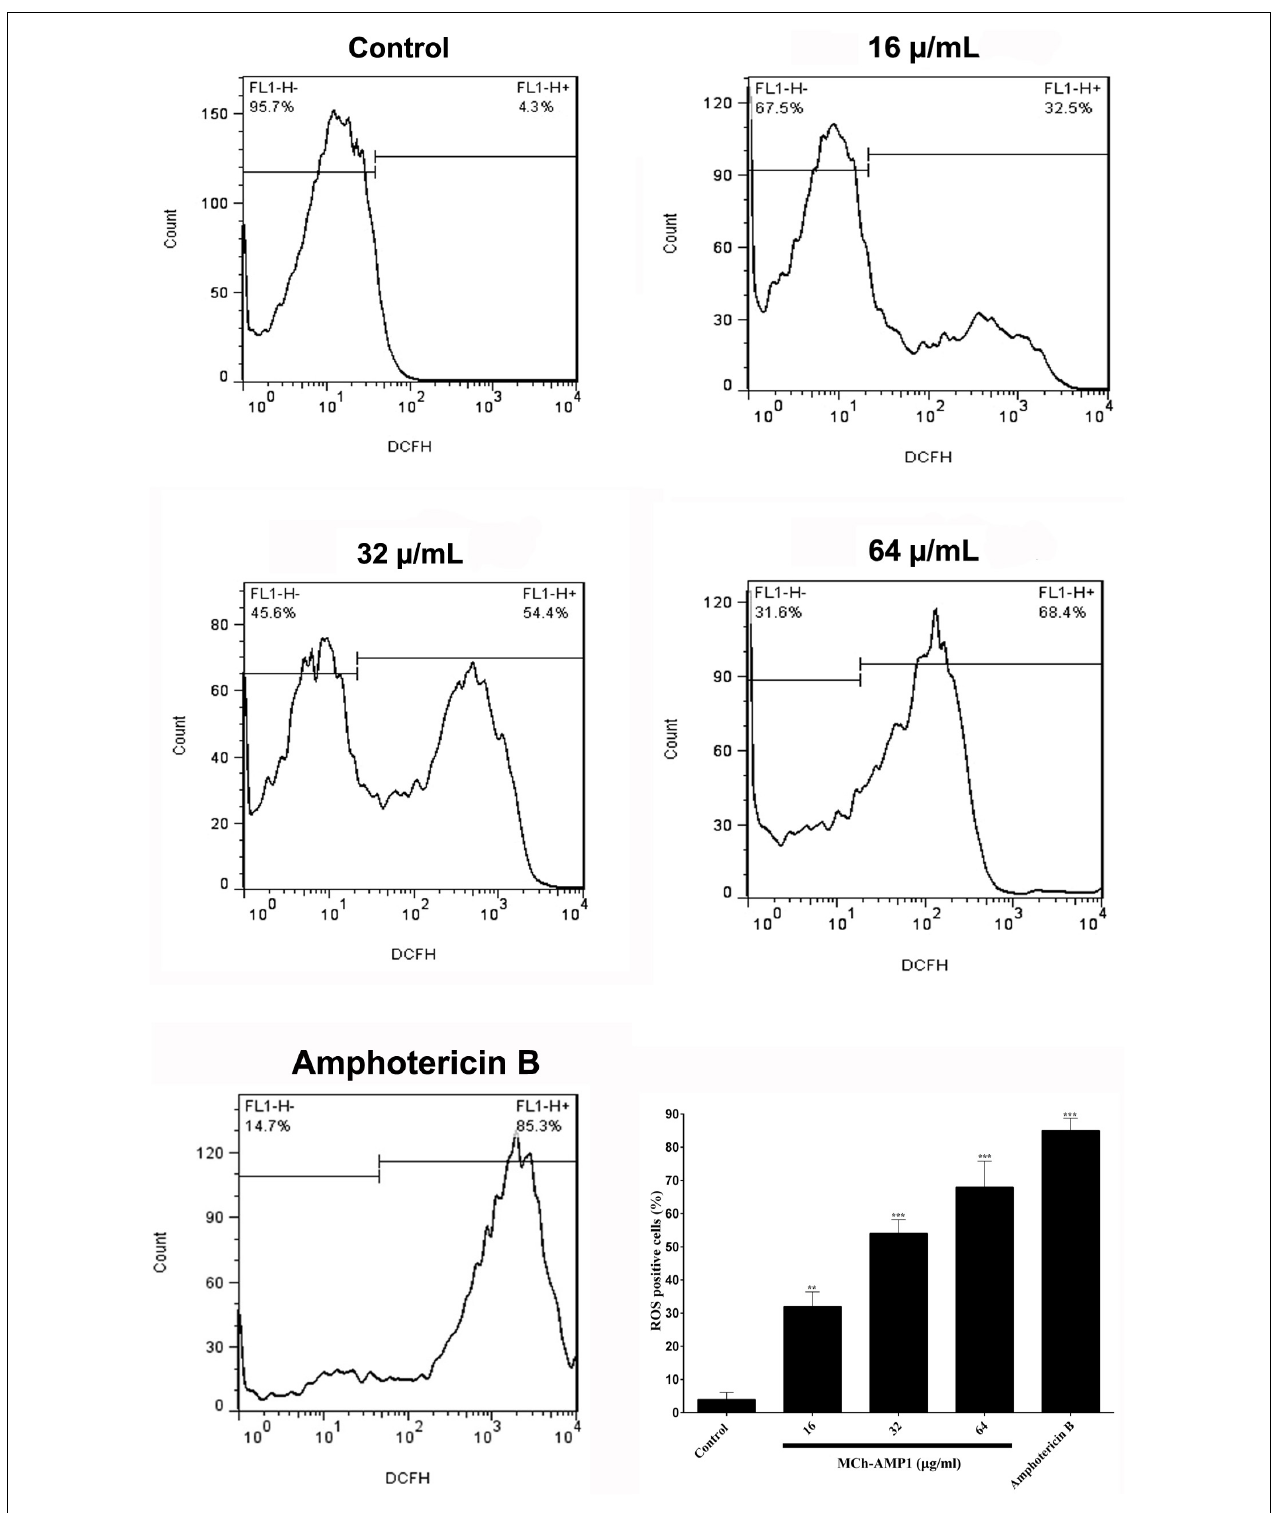
FIGURE 4 | Effect of MCh-AMP1 on ROS generation of C . albicans ATCC 10231. Flow cytometric analysis of the intracellular ROS levels was analyzed using DCFH-DA. Cells were treated with different concentrations of MCh-AMP1 (16–64 µ g/mL) and amphotericin B (2 µ g/mL) for 3 h and stained with DCFH-DA. Histogram analysis shows the percentage of C. albicans cells that produce ROS. The results are based on three independent experiments and represent the average, standard deviation, and P -values (** p ≤ 0.01, *** p ≤ 0.001) denote statistically significant differences from the effect of MCh-AMP1 on the control cells.